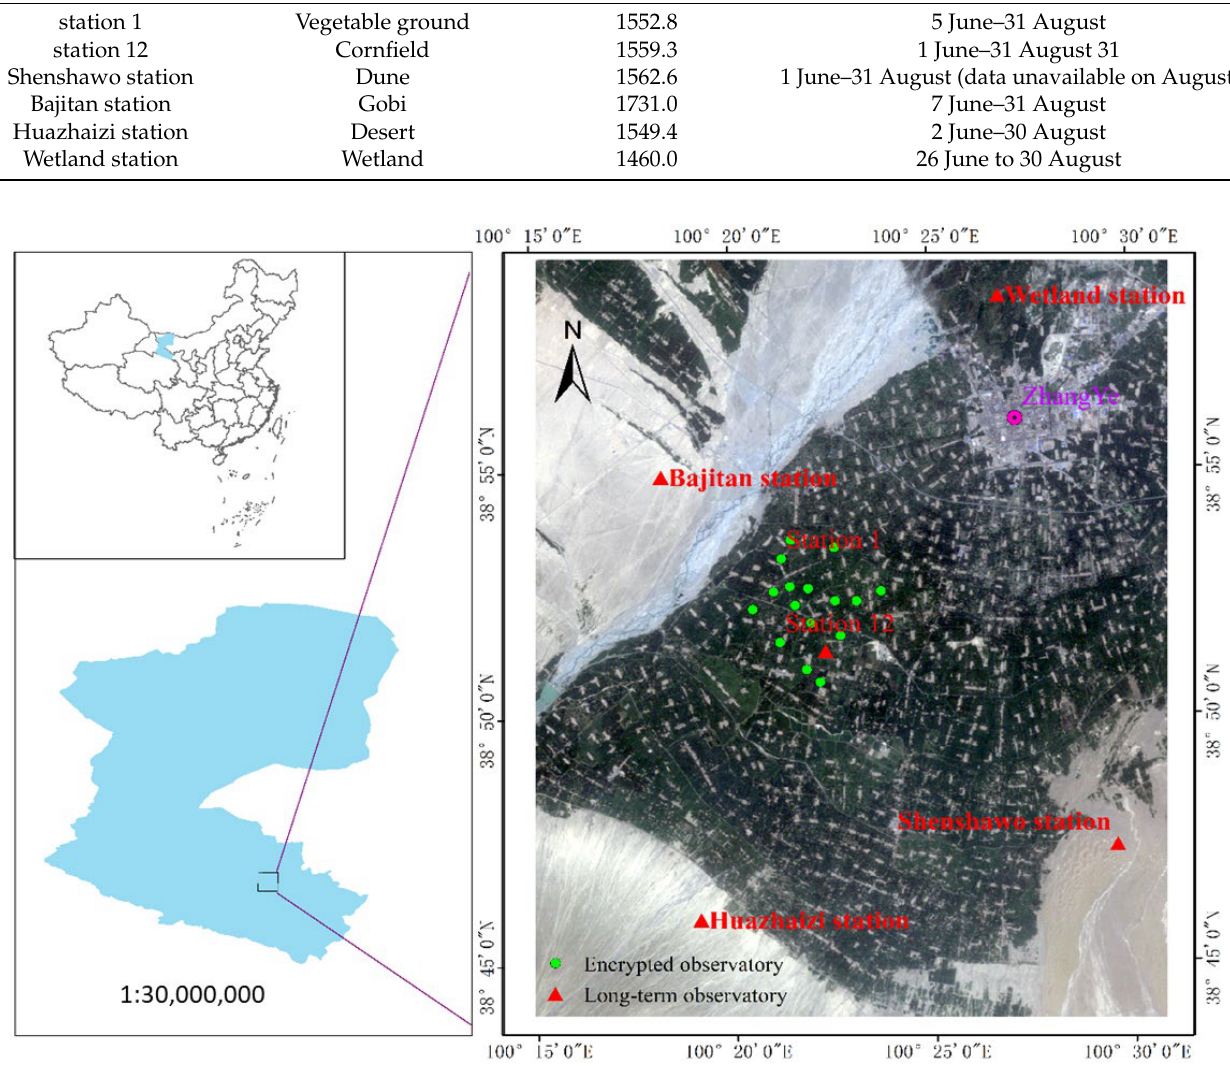
Figure 1. Geographical location and site distribution map of the research area.